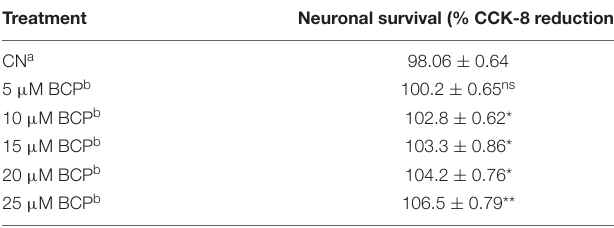
TABLE 3 | After 48 h of transfection, the effect of BCP on the viability of PC-12 cells for 24 h. Treatment